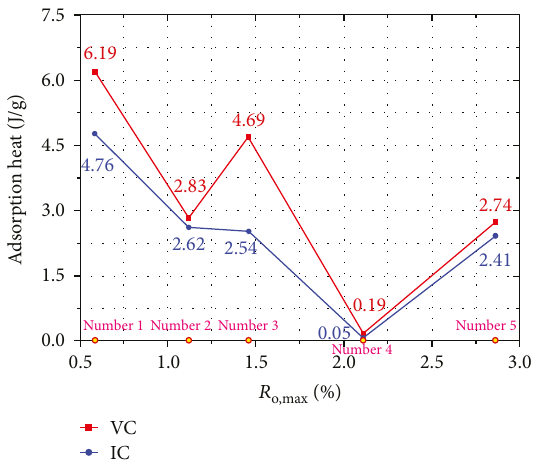
Figure 8: Curves of adsorption heat for maceral concentrates of di ff erent coals.